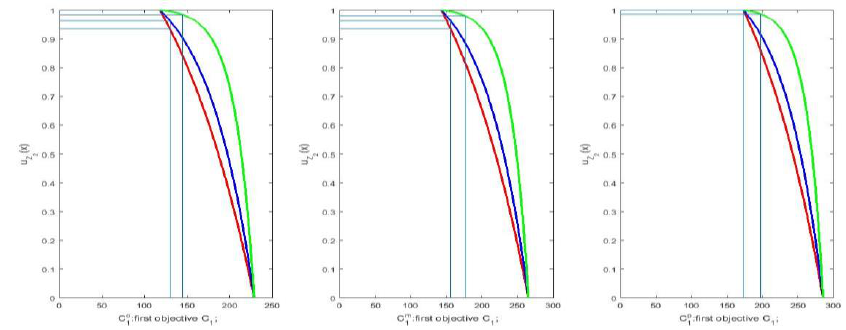
Figure 3. The degree of satisfaction of the first objective for α